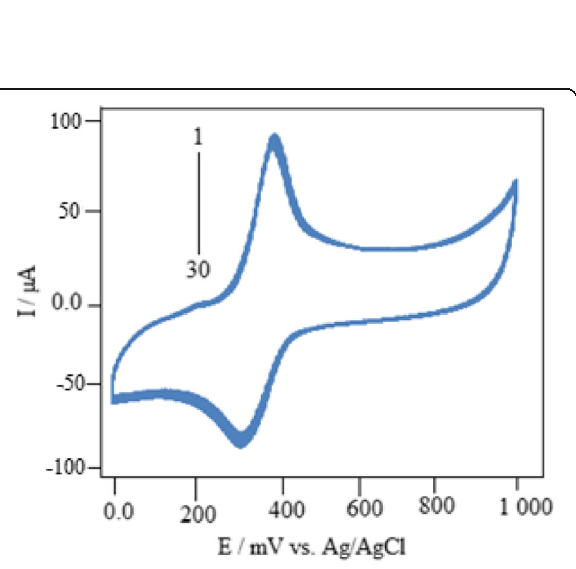
Fig. 6 Multiple CVs for 0.1 mM paracetamol in 0.1 M PBS (pH 4.0) at B 2 O 3 /MWCNT/GCE. Scan rate 100 mV s −